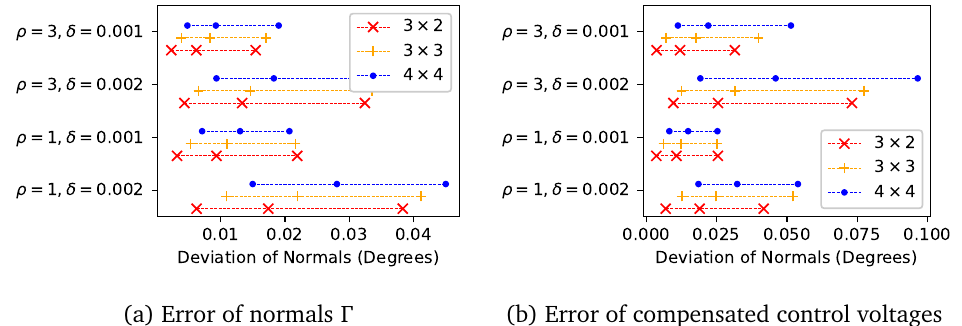
Figure 5: Accuracy of the algorithm for estimating normal vectors Γ . We show both the angular deviations of the estimated rows of Γ to the true values as well as the misalignment of the compensated coordinate system.